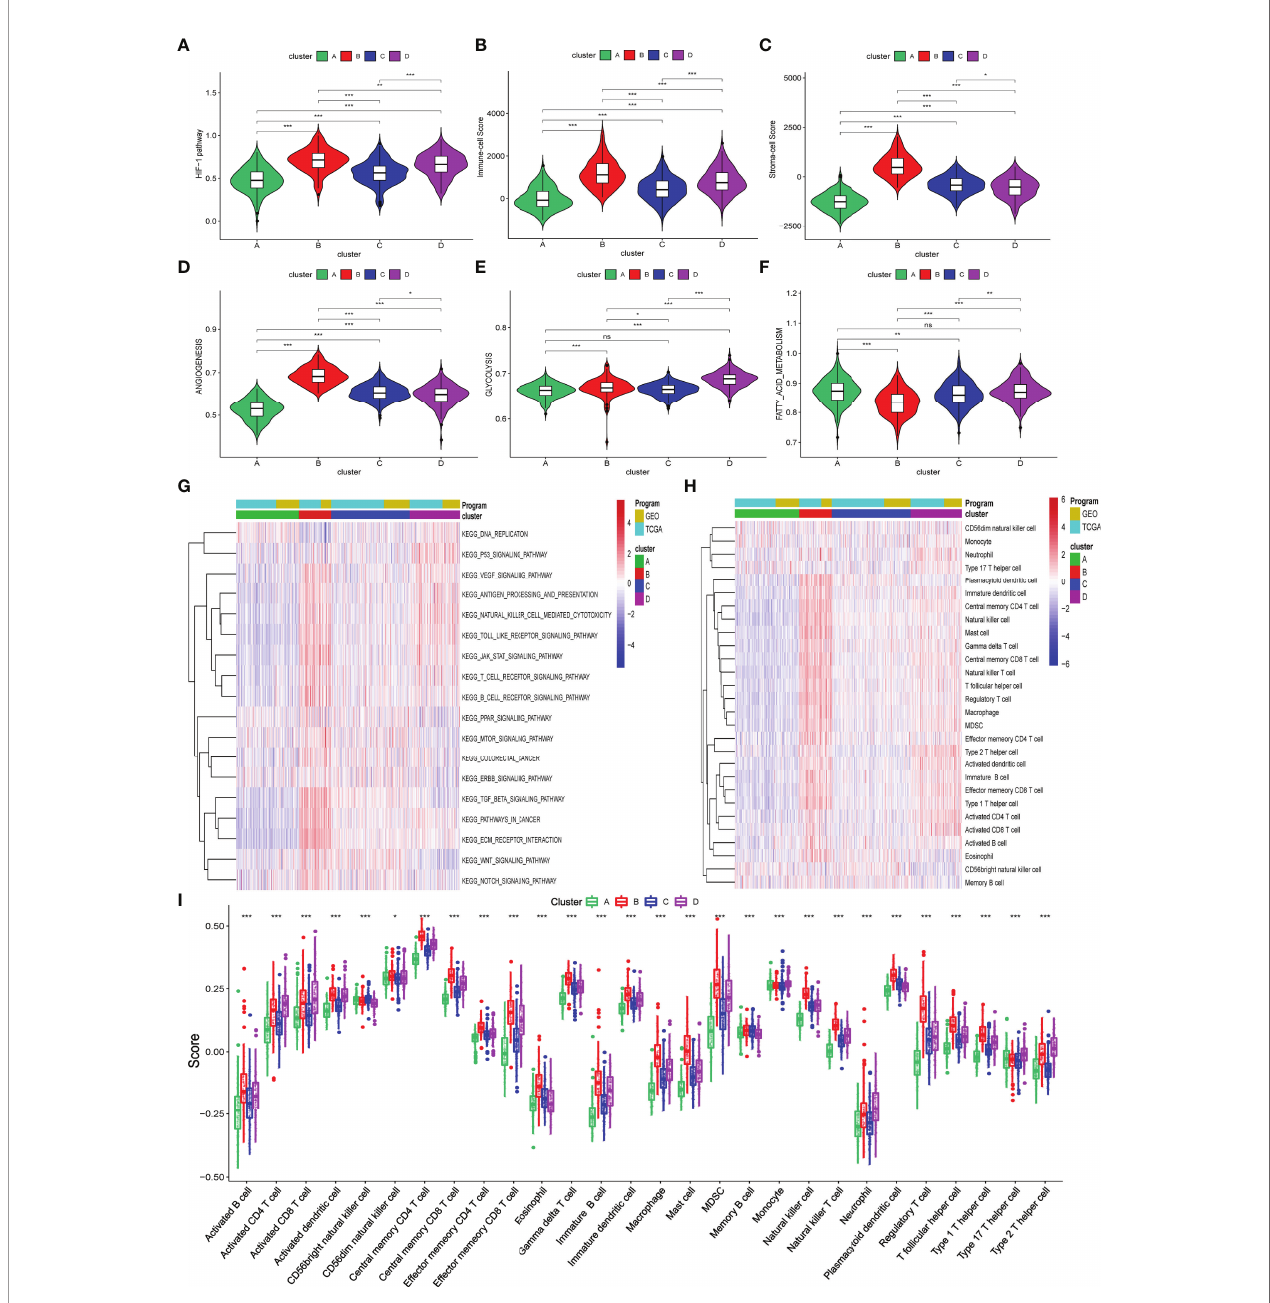
FIGURE 2 | Biological processes and immune in fi ltration in different hypoxia-related clusters. (A – F) Six biological processes were different among these four hypoxia-related clusters. (G) Heatmap about KEGG pathways among four hypoxia-related clusters. (H , I) In fi ltration immune cells were signi fi cantly distinct in these four clusters. ( p >0.05 ns; p < 0.05 *; p < 0.01 **; p < 0.001